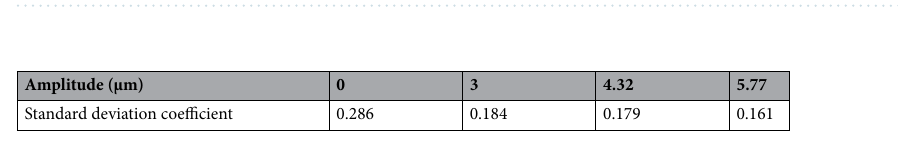
Figure 12. Variation of relative interference with amplitude.